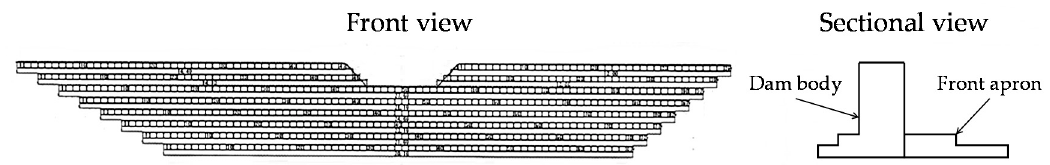
Figure 2. The front and sectional views of a timber check dam. Table 1. Scale of the targeted check dams.